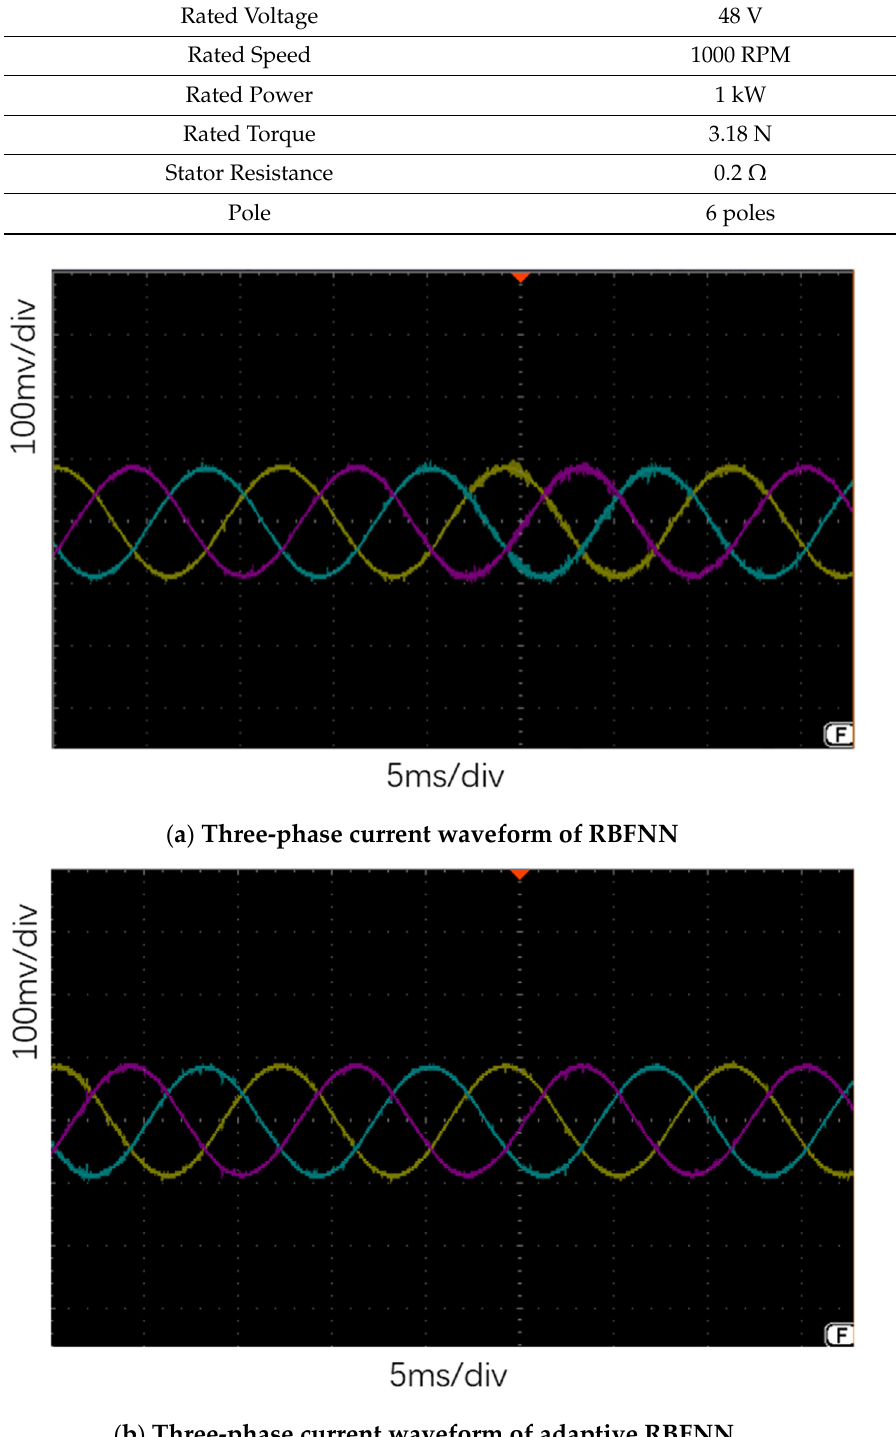
Figure 13 Three-phase stator current waveform using conventional RBFNN and adaptive RBFNN. Figure 13. Three-phase stator current waveform using conventional RBFNN and adaptive